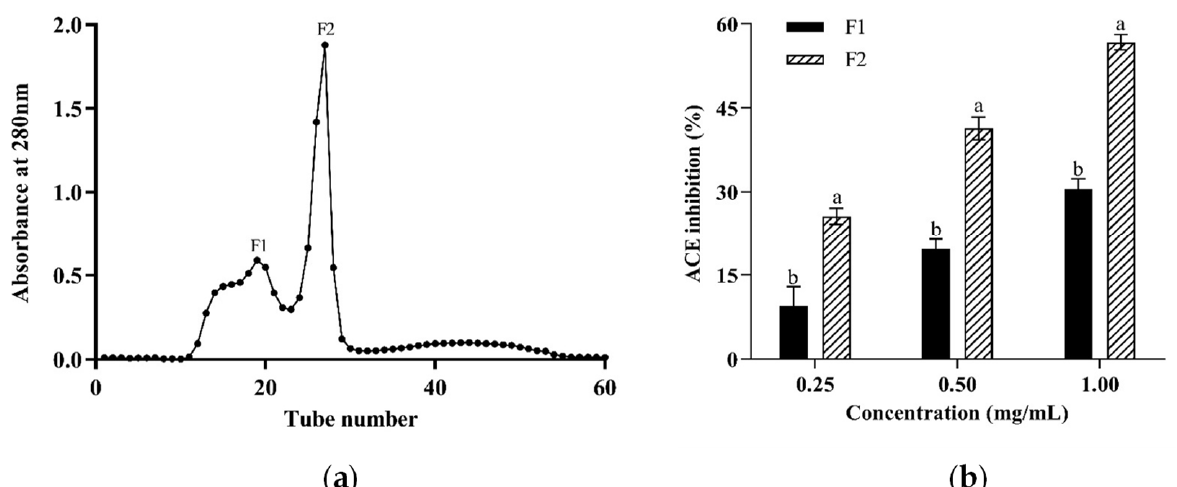
Figure 3. Sephadex G ‐ 25 gel chromatography and ACE inhibitory activity of subfractions (F1, F2) from CPH3. (a) Sephadex G ‐ 25 gel chromatography. (b) ACE inhibitory activity. The results are presented as the means ± SD (n = 3). Different letters indicate significant differences at p < 0.05.